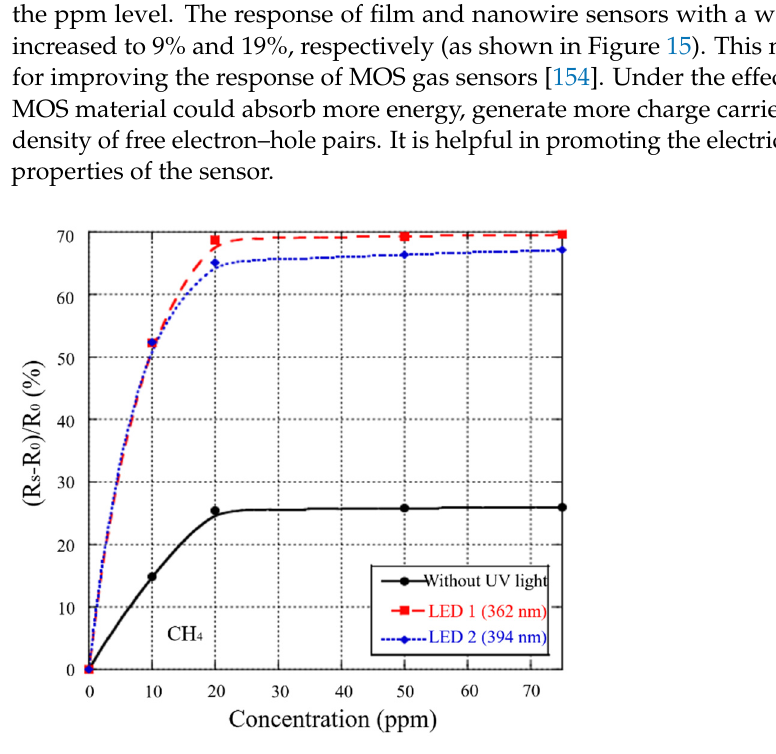
Figure 15. Performance of a gas sensor in the absence and presence of UV irradiation. Reprinted from [154] copyright (2016), with permission from Elsevier.